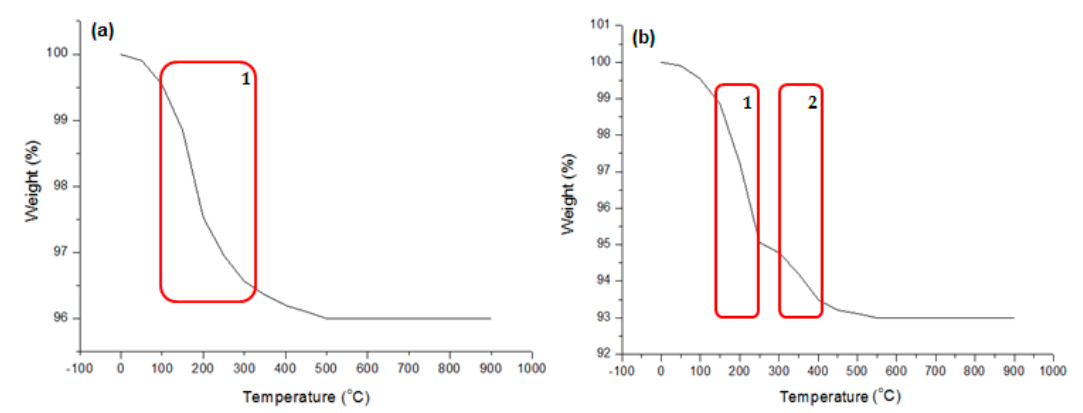
Figure 4. Thermogravimetric Analysis (TGA) curves of: ( a ) Sample S1 showing degradation of reducing agent (highlighted area in red); and ( b ) Sample S2 showing degradation of surfactants on the NP surface (highlighted area in red).